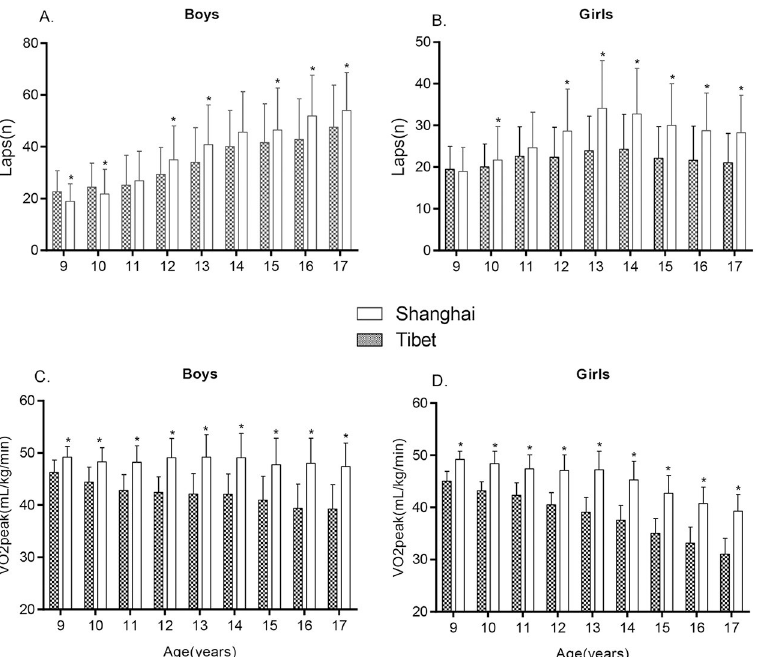
Fig 1. Laps(n) and VO 2 peak(mL/kg/min) in 20mSRT of students aged 9–17 years in Tibet and Shanghai. (A) 20mSRT performance (laps) in boys; (B): 20mSRT performance (laps) in girls; (C): Predicted VO 2peak in boys”; (D): Predicted VO 2peak in girls; “20mSRT” refers to the 20m shuttle run test; “Tibet” refers to children and adolescents aged 9–17 years residing in Tibet; “Shanghai” refers to children and adolescents aged 9–17 years from the Shanghai Province. All values are presented as means. � p < 0.05 vs. Tibet